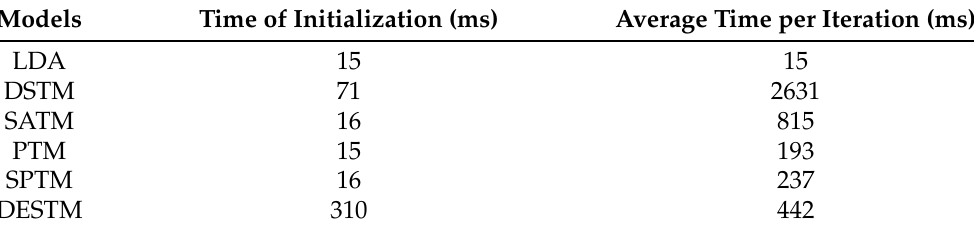
Table 4. Time of initialization and average time of each